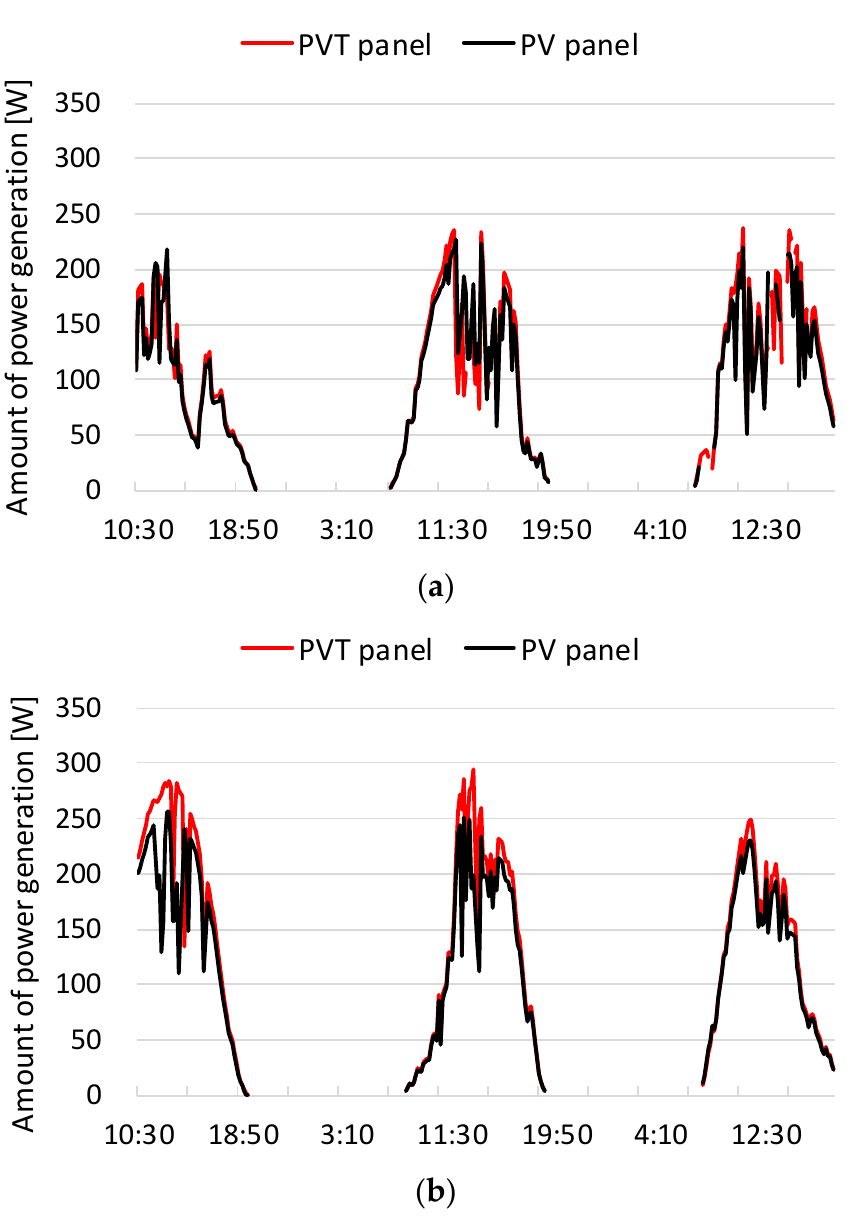
Figure 8. Change in power generated by PV and PVT panels: ( a ) summer; ( b ) winter. The power generation efficiency of PV and PVT panels was calculated based on the measured solar radiation and power generation. As shown in Figure 10, the power generation efficiency of the PVT panel was 19.0% in summer and 20.3% in winter, and the corresponding value for PV was 18.0% in summer and 18.7% in winter. Based on this, it can be confirmed that the increase in the power generation efficiency resulting from the air flow under the panel was approximately 8.6%. In addition, as shown in Figure 11, the solar energy utilization efficiency for PVT was 67.2%, based on an average annual heat-collecting effect of approximately 47.7%, which was a significant increase compared with the corresponding value of 18.3% for PV. However, for the application of PVT, it is necessary to not only increase the amount of power generated but also analyze the correlation with the heat load on the target building; additionally, it is crucial to review control measures at higher